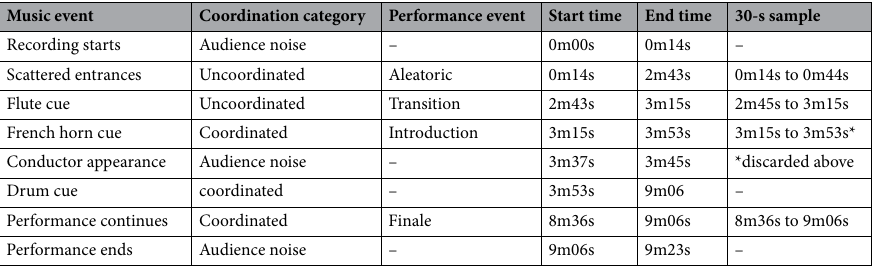
Table 2. Coordination category and performance event labels for recurrence quantification analysis. 30-s samples used for analysis are indicated. Audience noise was discarded before